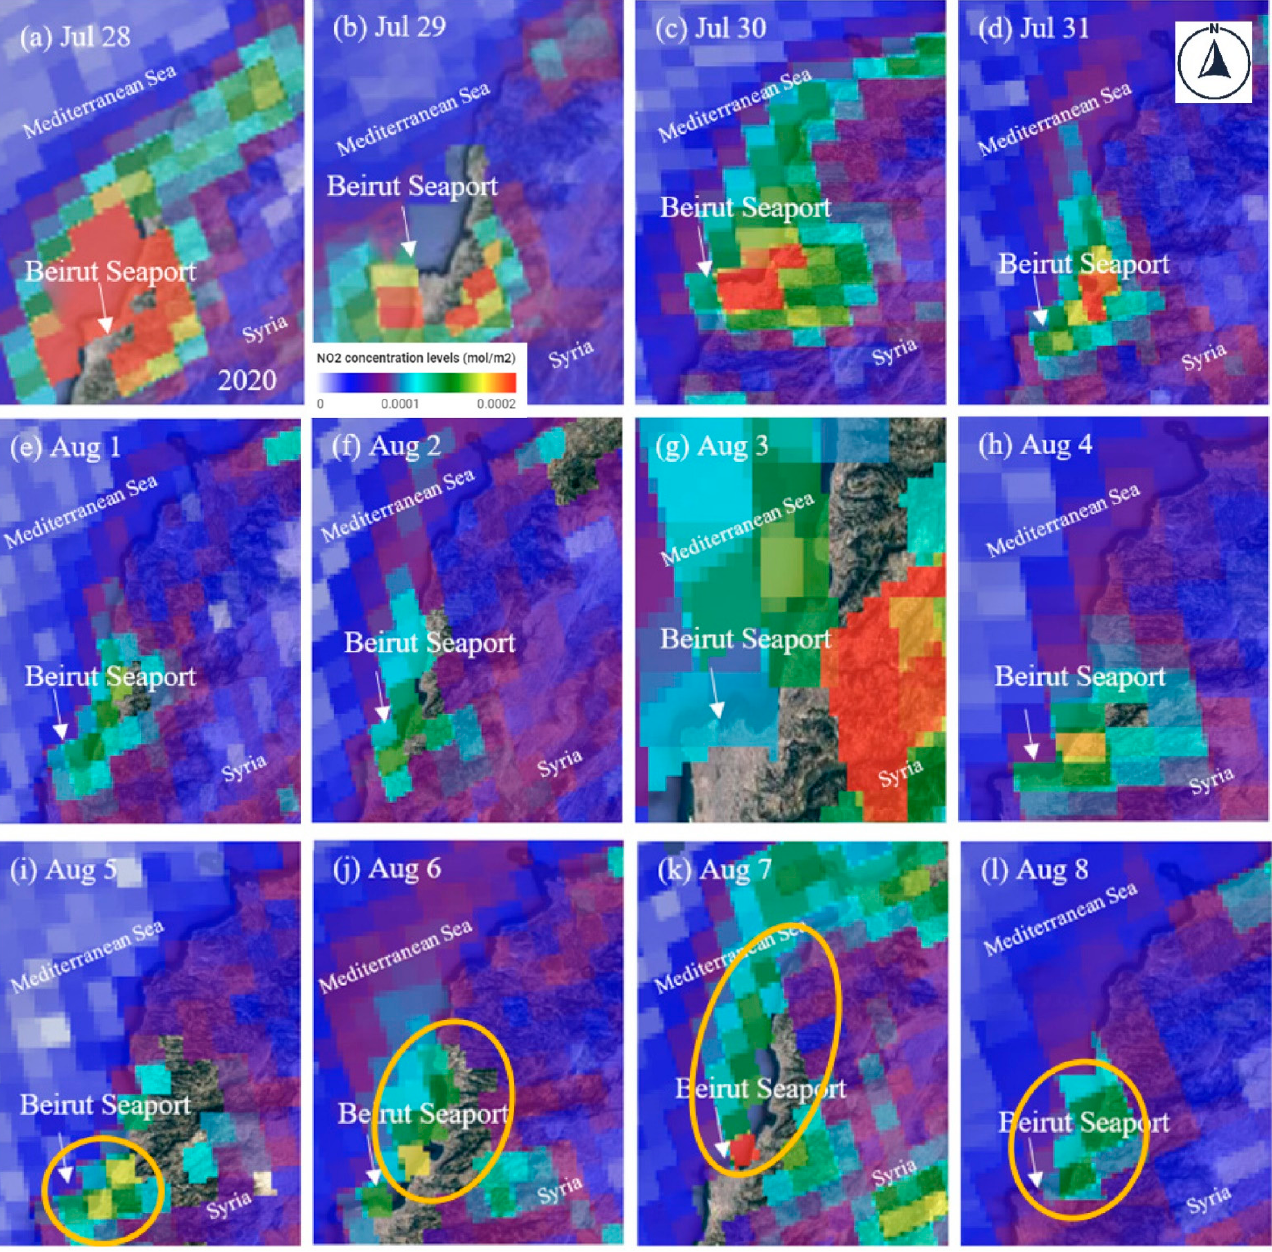
Figure 3. NO 2 concentrations over Beirut, Lebanon 28 July–11 August 2020. The 4 August 2020 Beirut blast occurred around 18:00 Beirut local time. NO 2 plumes from 5 to 8 August are indicated by the yellow ovals.